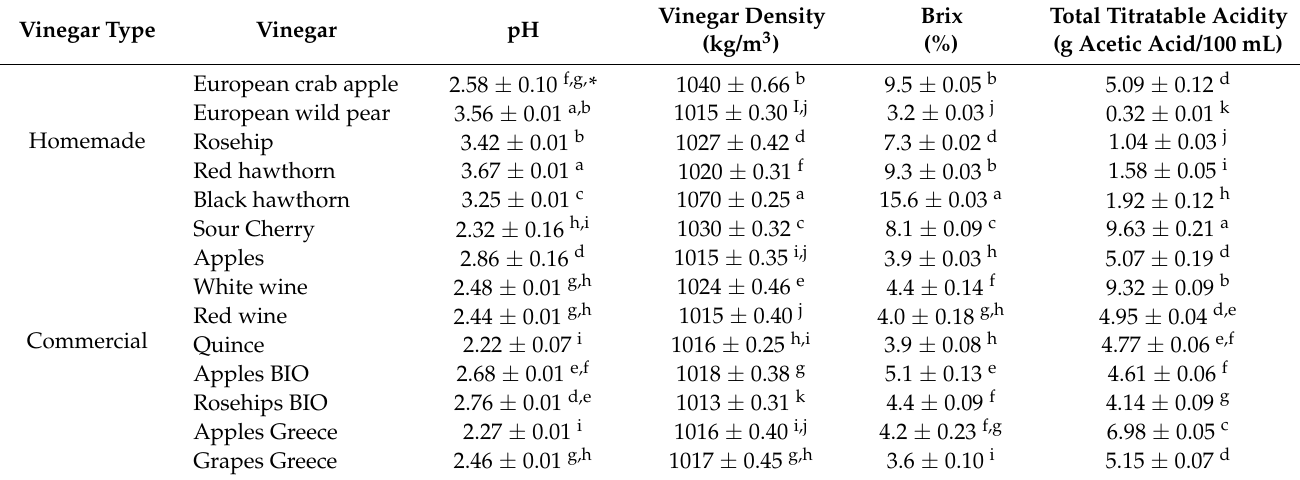
Table 1. Physicochemical properties of the homemade and commercial vinegars.